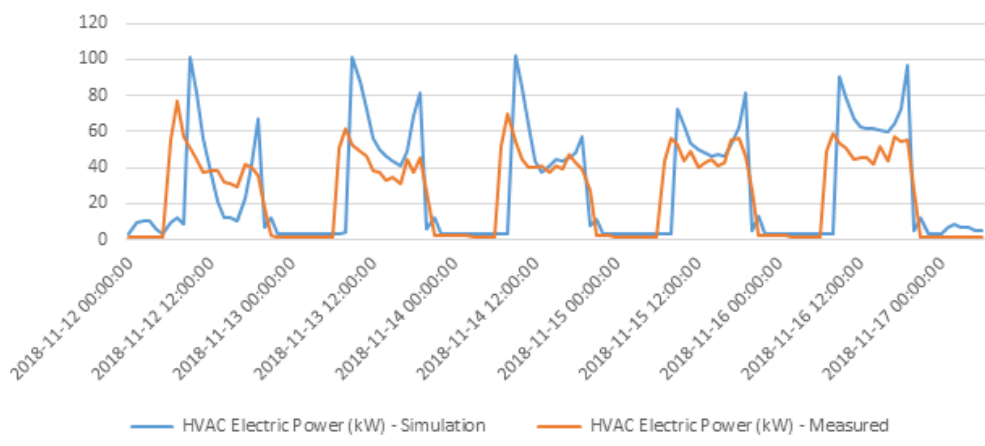
Figure 7. Simulated versus measured HVAC electric power for the week from 12/11/18 to